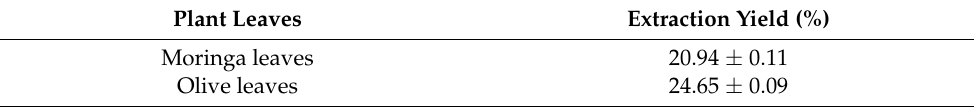
Table 1. Yield extracts from Moringa oleifera and olive leaves, per 100 g. Plant